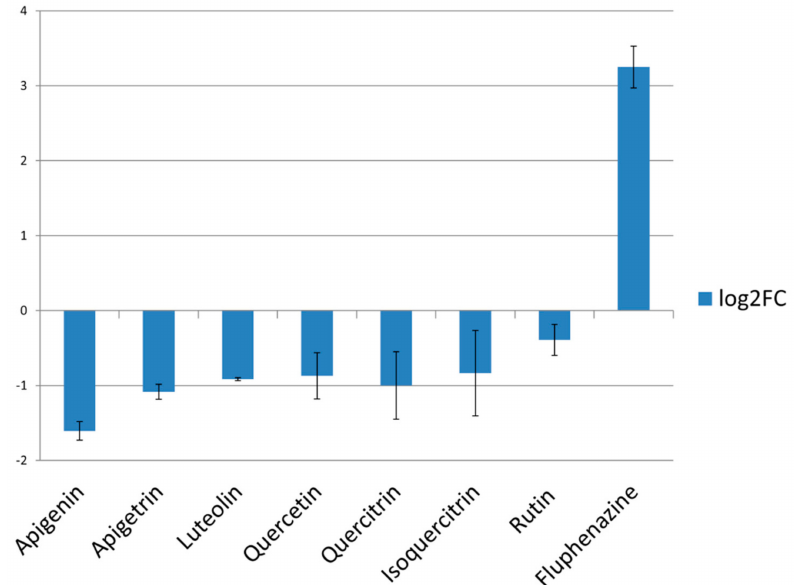
Figure 3. Expression levels CDR1 after treatment of MIC of compounds. Fluphenazine was used as positive control. Values are expressed as Log2 fold changes (log2FC) of Relative Quantification (RQ) values, averages of two biological replicates.